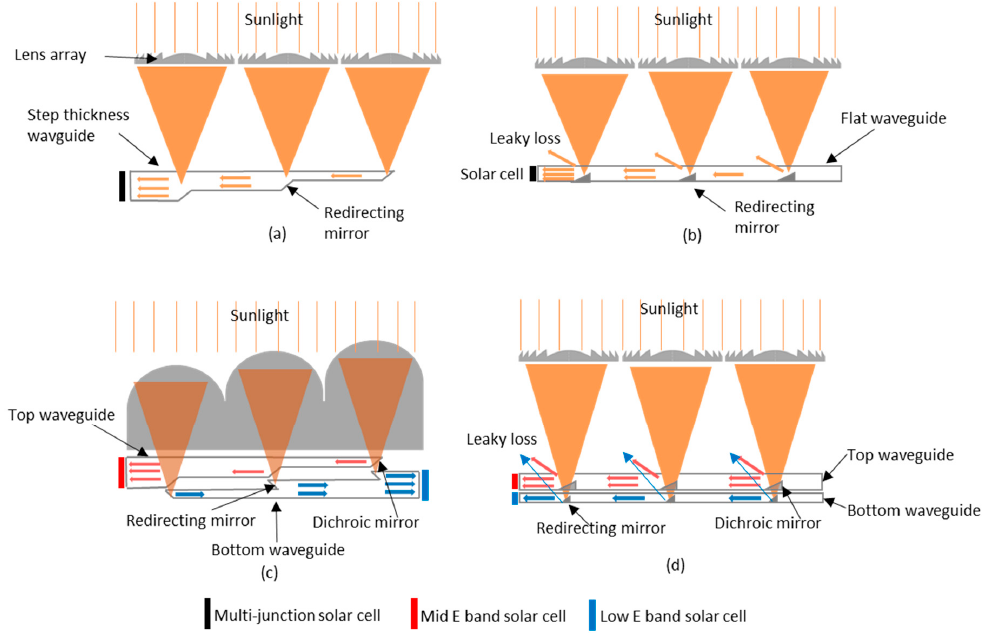
Figure 1. Concentrating photovoltaic (CPV) system based on waveguides: ( a ) lossless structure and ( b ) lossy structure. Spectral splitting CPV system based on double waveguide: ( c ) stepped thickness waveguide and ( d ) our proposed double flat waveguide.